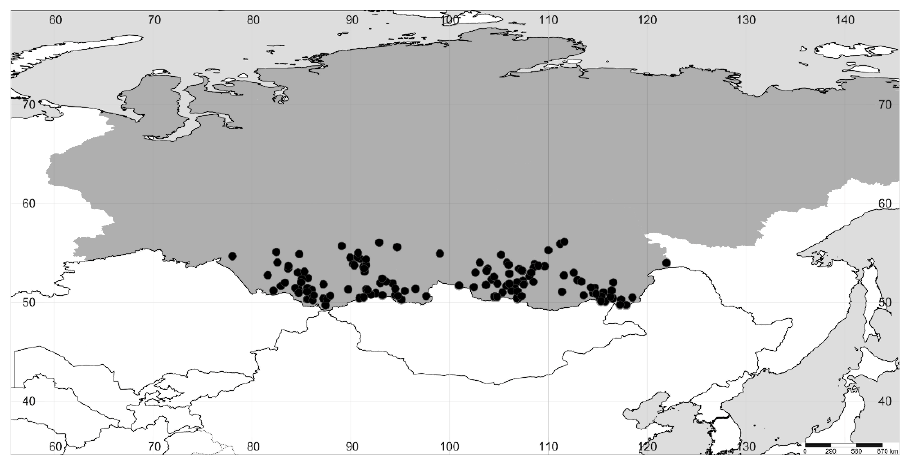
Figure 2. The distribution of A. hybrida in Siberia (the region itself is highlighted in gray).